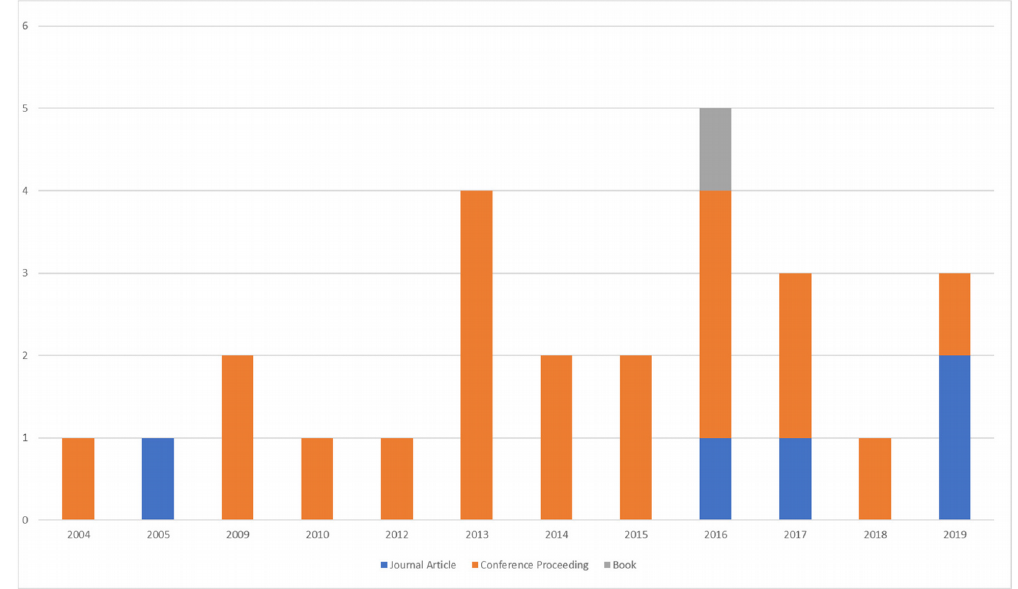
Figure 4. Distribution of products by year and type of